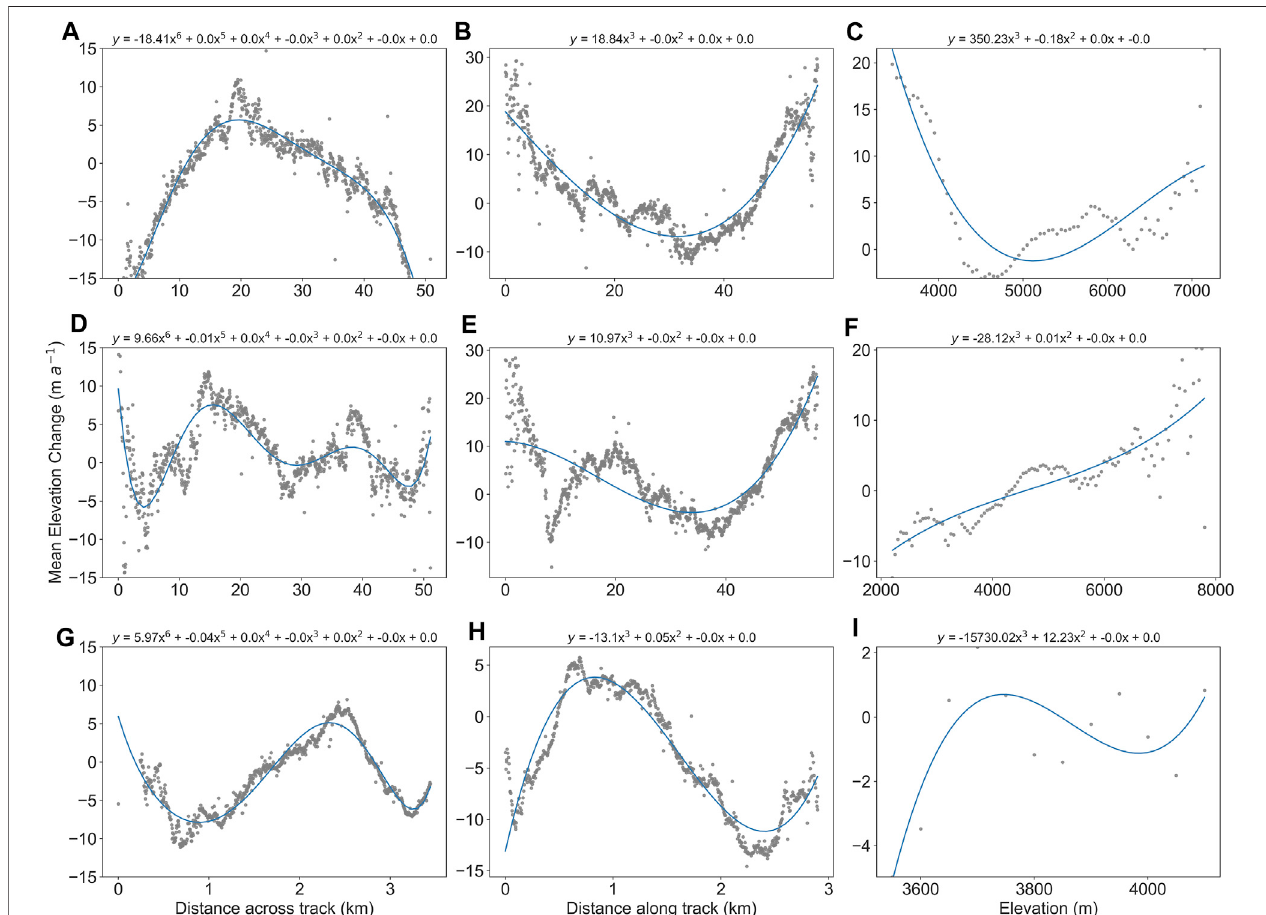
FIGURE 2 | Non-linear elevation biases over stable (non-glacierized) terrain. The top two rows show biases between the 2013 HMA DEM and the 1970 Corona DEMfortheNorthernDEM (A – C) andtheSouthernDEM (D – F) .Thebottomrowshowstheelevationbiasesbetweenthe2019UAVDEMandthe2013HMADEMforthe lower part of Ponkar Glacier (G – I) . From left to right, graphs represent: across track biases, along track biases and vertical biases, respectively. The blue lines show the polynomials used to remove non-linear co-registration biases (sixth-order for the across-track, and third-order for along-track and elevation biases.